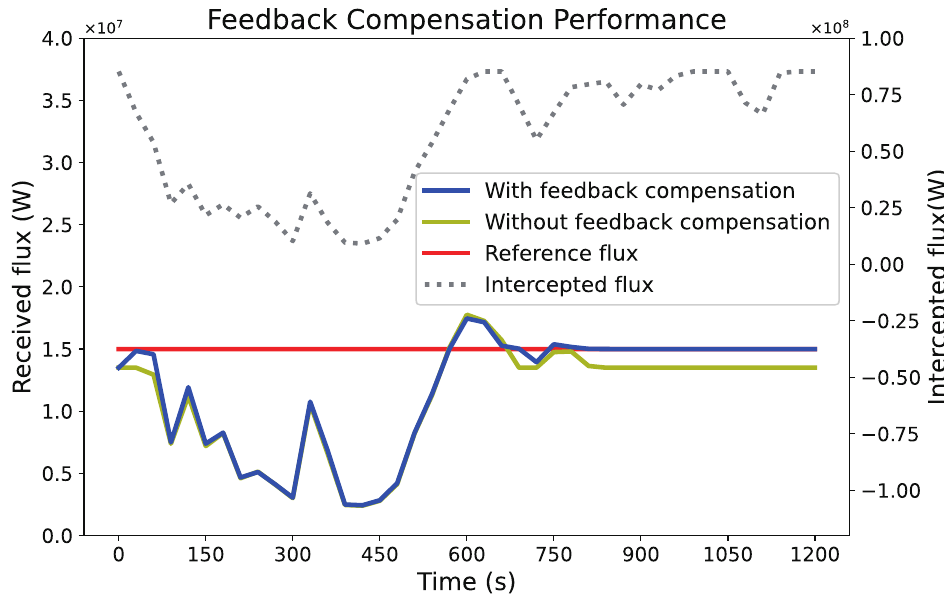
Figure 11. The feedback compensation analysis of the MPC-based aiming